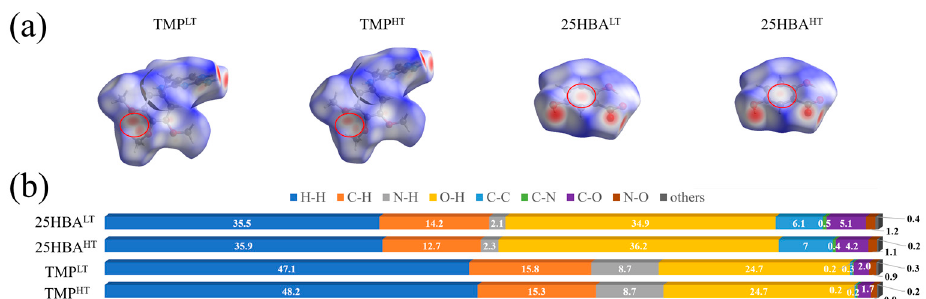
Figure 9. ( a ) 3D Hirshfeld surface of TMP and 25HBA at high/low temperatures; ( b ) percentage contributions of various intermolecular contacts to the Hirshfeld surface area.